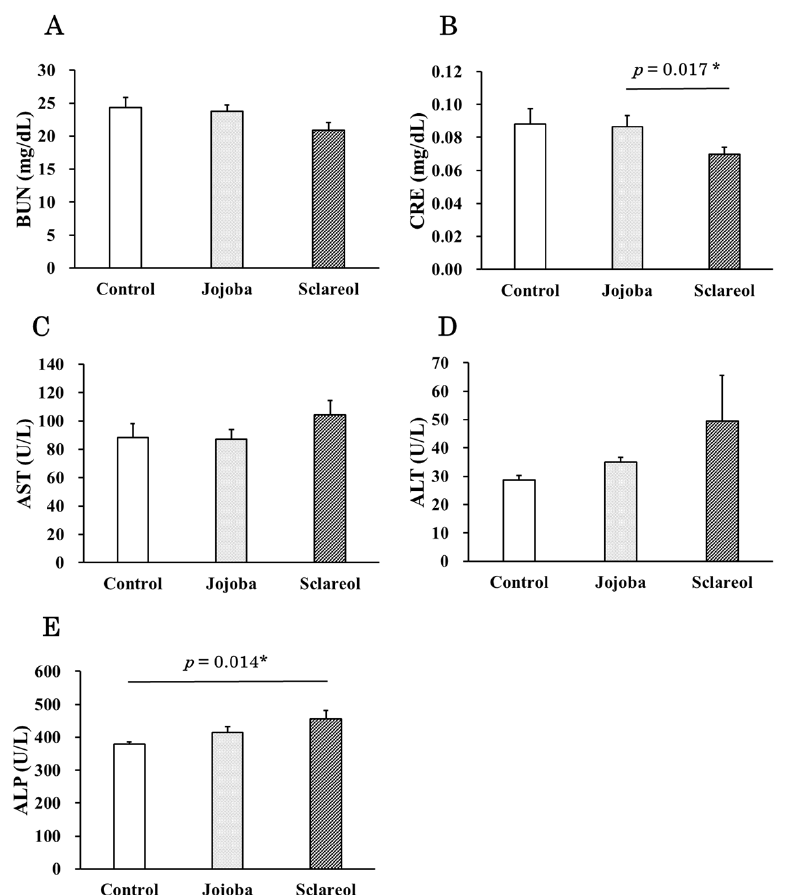
Figure 5. Plasma levels of ( A ) BUN, blood urea nitrogen; ( B ) CRE, creatinine; ( C ) AST, aspartate aminotransferase; ( D ) ALT, alanine aminotransferase; and ( E ) ALP, alkaline phosphatase. Control, naïve control group ( n = 6); Jojoba, jojoba oil-administered group ( n = 6); Sclareol, sclareol-administered group ( n = 4). Values are presented as the means ± SEs. A one-way analysis of variance and Tukey’s post-hoc test were performed using the SPSS 24.0 statistical software package to compare the means of the three groups. * p < 0.05.